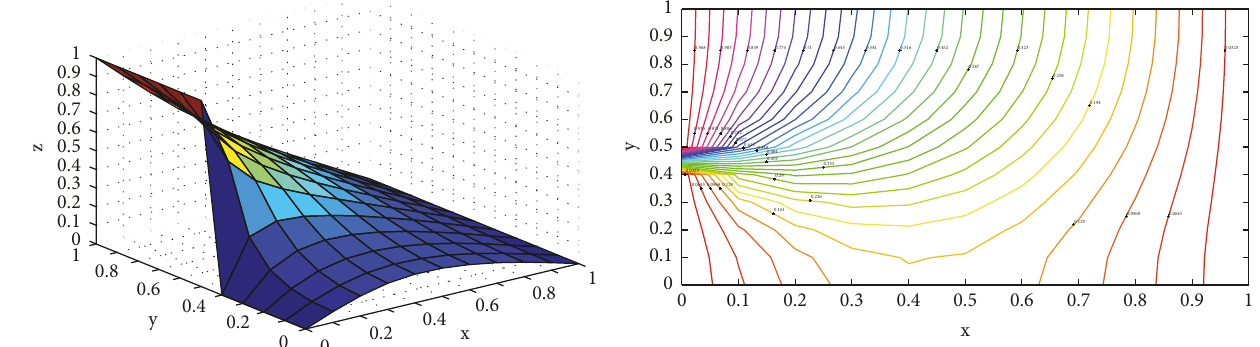
Figure 2: Pollutant distribution in a street tunnel with advection only in 𝑥 direction.